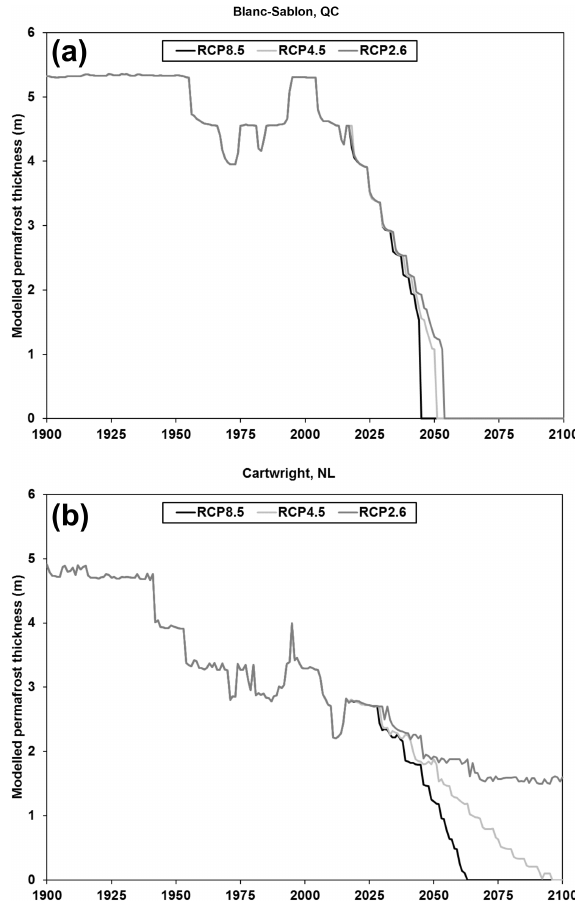
Figure 11. Permafrost thickness modelled with NEST for 1900– 2100 for (a) Blanc-Sablon and (b) Cartwright. Future predictions are for RCP2.6, RCP4.5, and RCP8.5.